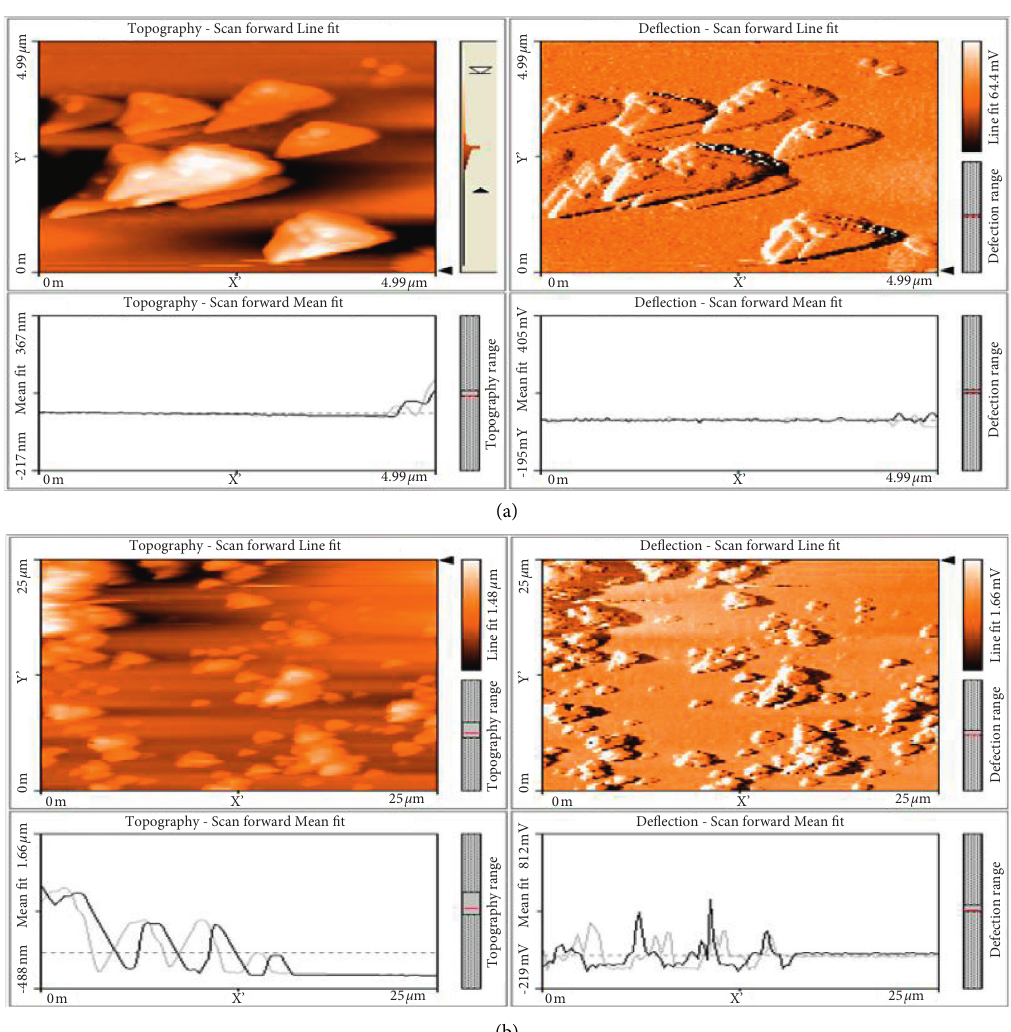
Figure 6: AFM analysis of (a) TiO 2 (b) and A. paniculata plant extract.